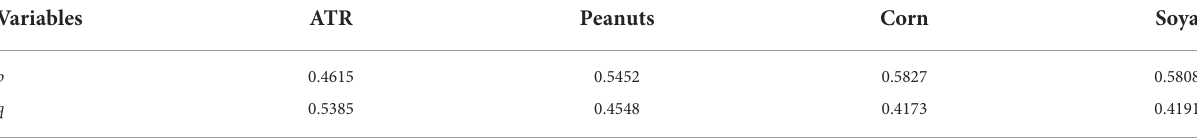
TABLE 11 p and q values derived for the studied